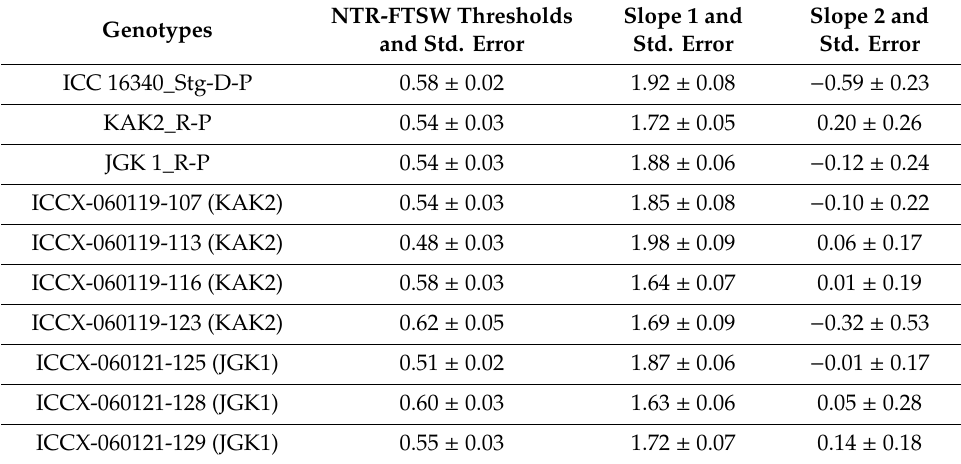
Table 2. Regression analysis of transpiration response to soil drying of green cotyledon trait donor genotype ICC 16340, recurrent yellow cotyledon elite cultivars KAK-2 and JGK1 and backcross introgression lines of the green cotyledon trait in these elite cultivar